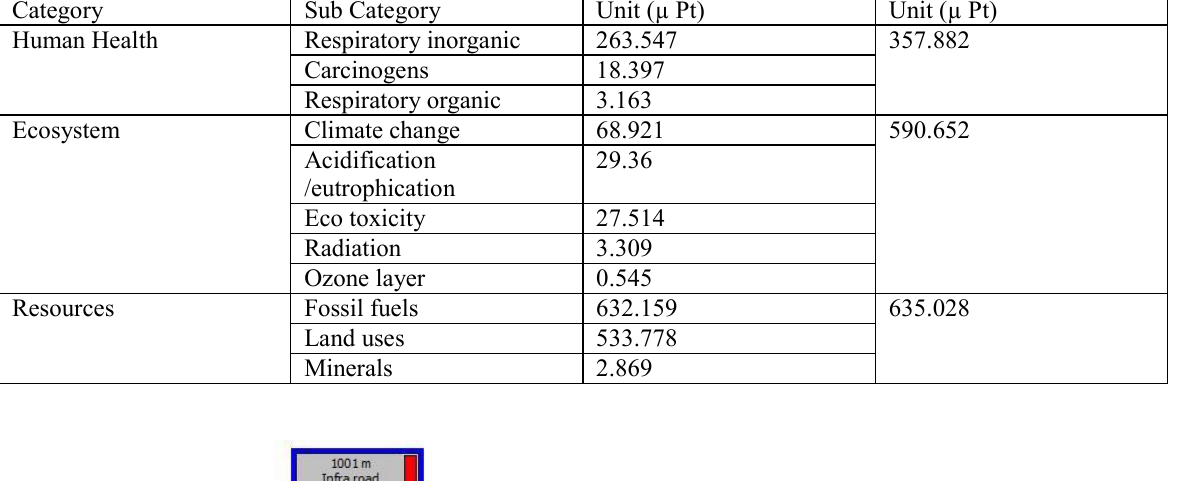
Weighting analysis of the categories.